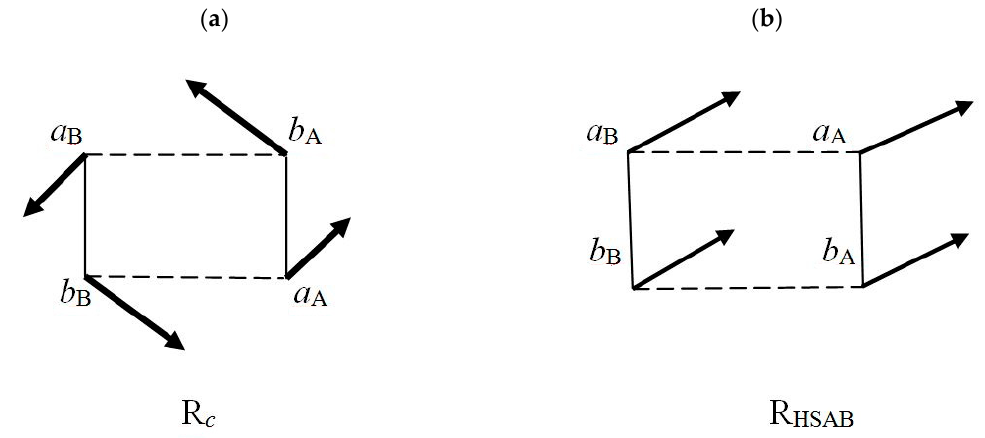
Figure 2. Qualitative diagrams of the conrotatory pattern of the resultant site -currents { j ( λ )} in the complementary complex R c ( a ) and their translational pattern in the R HSAB arrangement ( b ) of the acidic A = ( a A | b A ) and basic B = ( a B | b B )